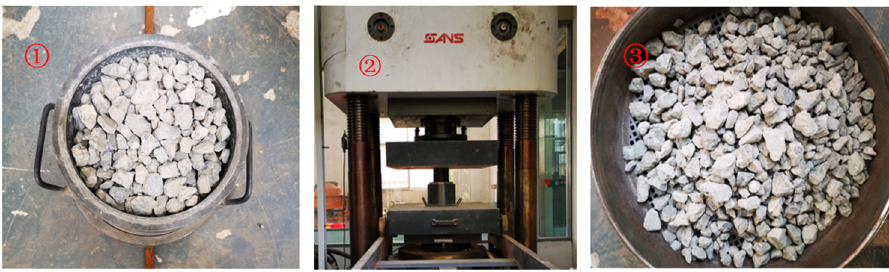
Figure 4: Determination process of crushing value of RA. ( 1 ) Sample and put into the mold; ( 2 ) Apply load; ( 3 ) Sieve the sample.